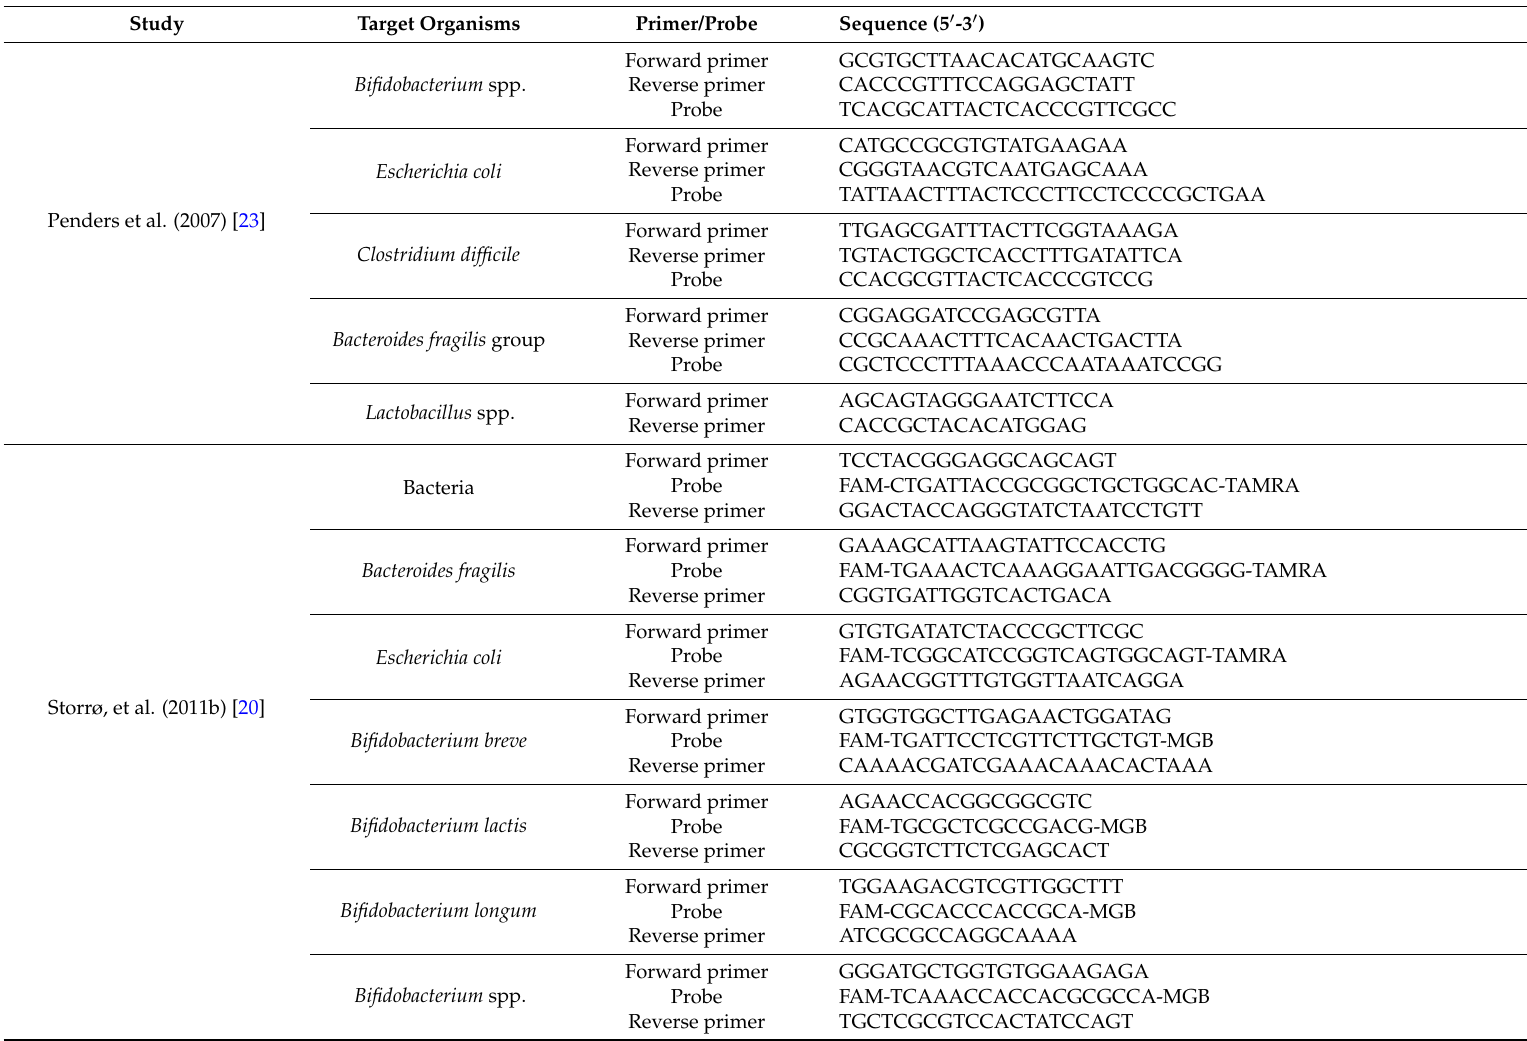
Table 3. Sequence of 16S rRNA primers and